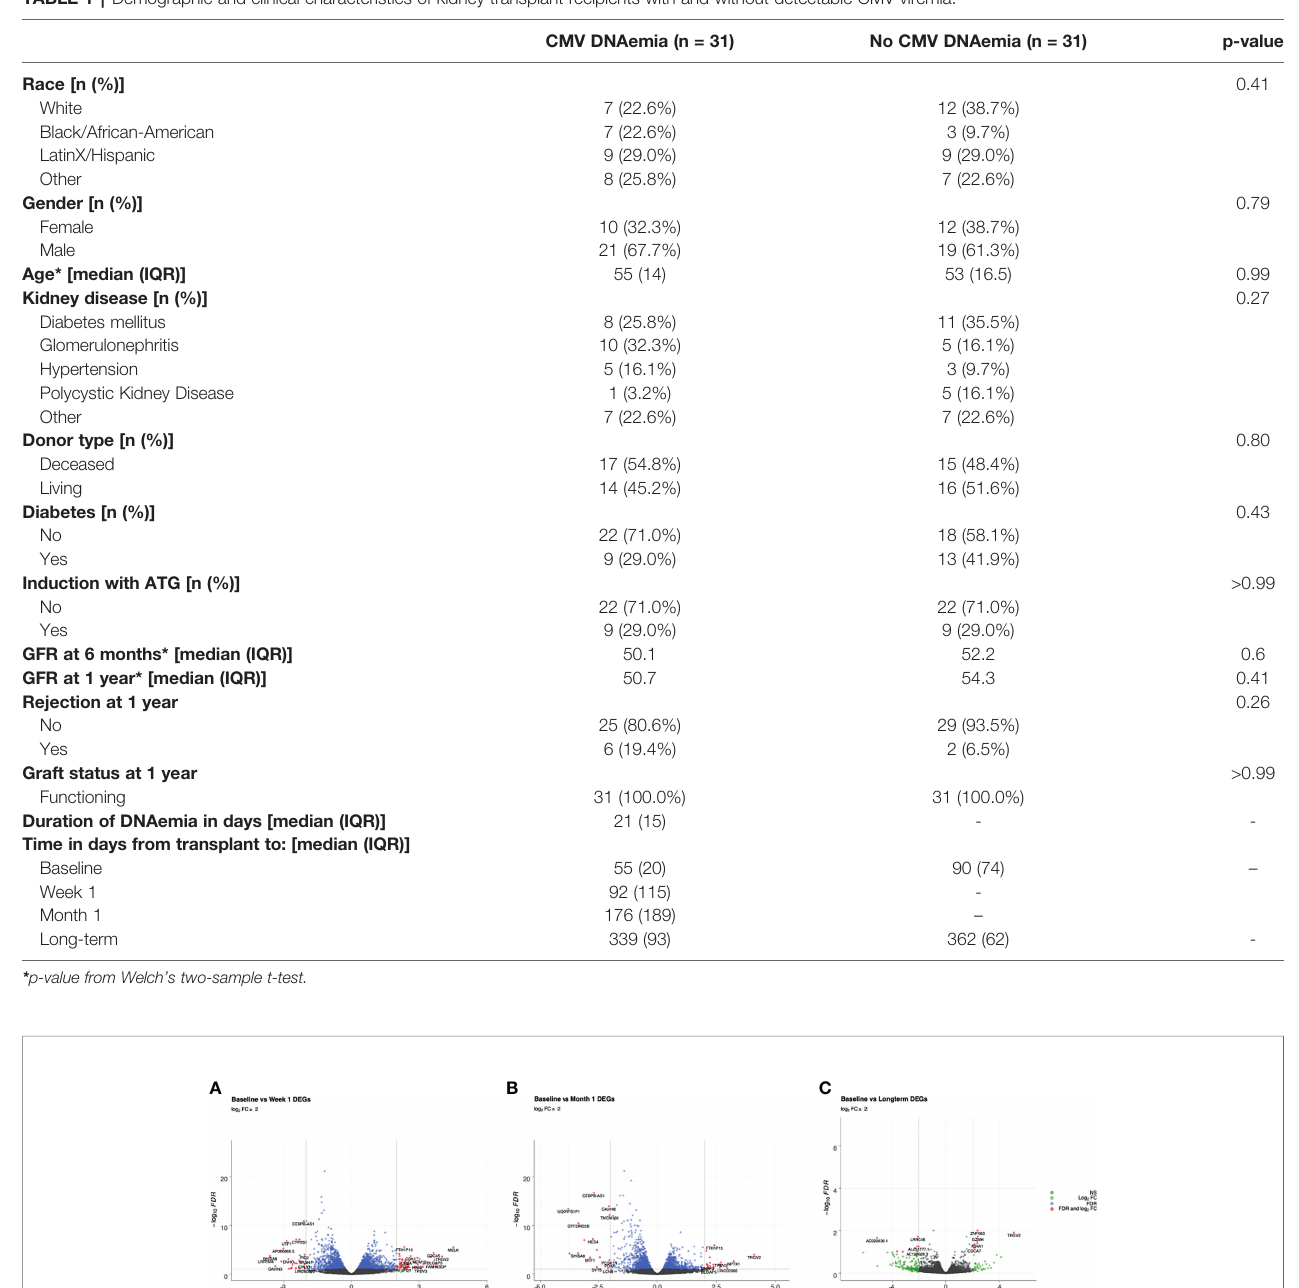
TABLE 1 | Demographic and clinical characteristics of kidney transplant recipients with and without detectable CMV viremia.